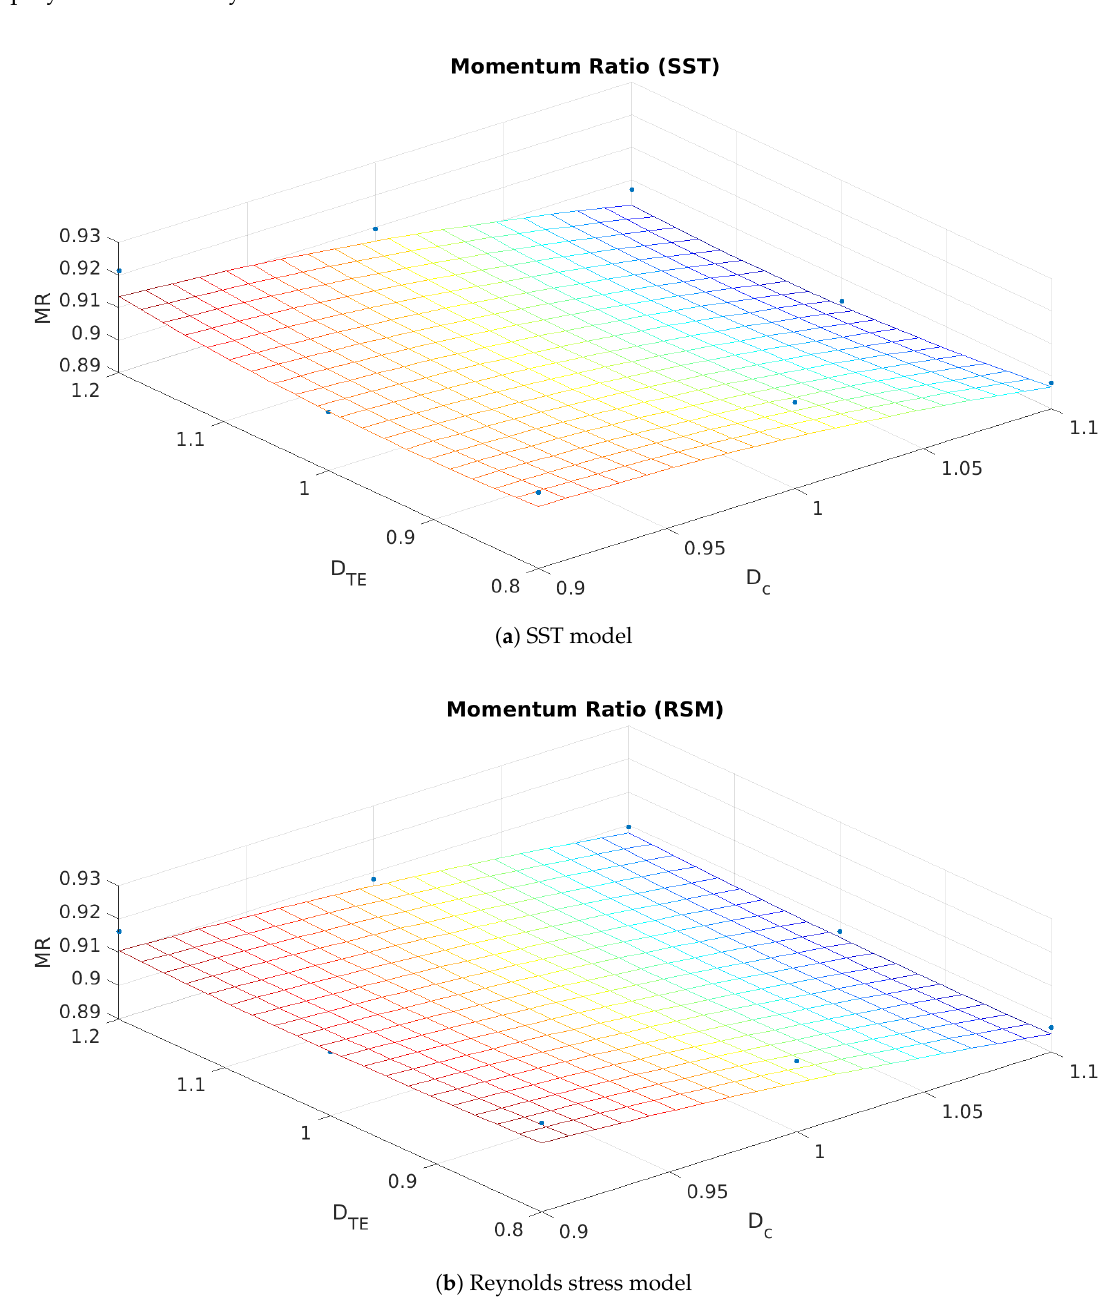
Figure 8. Momentum Ratio MR (Hermite